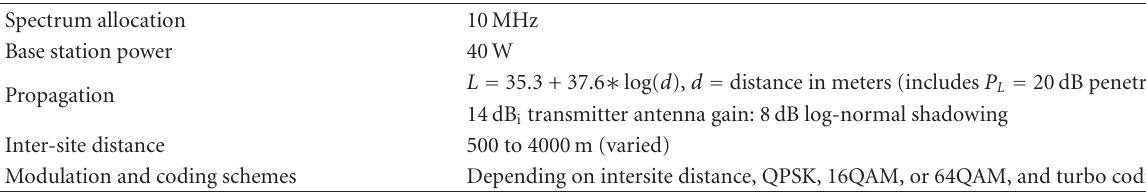
Table 5: Radio network simulation parameters.